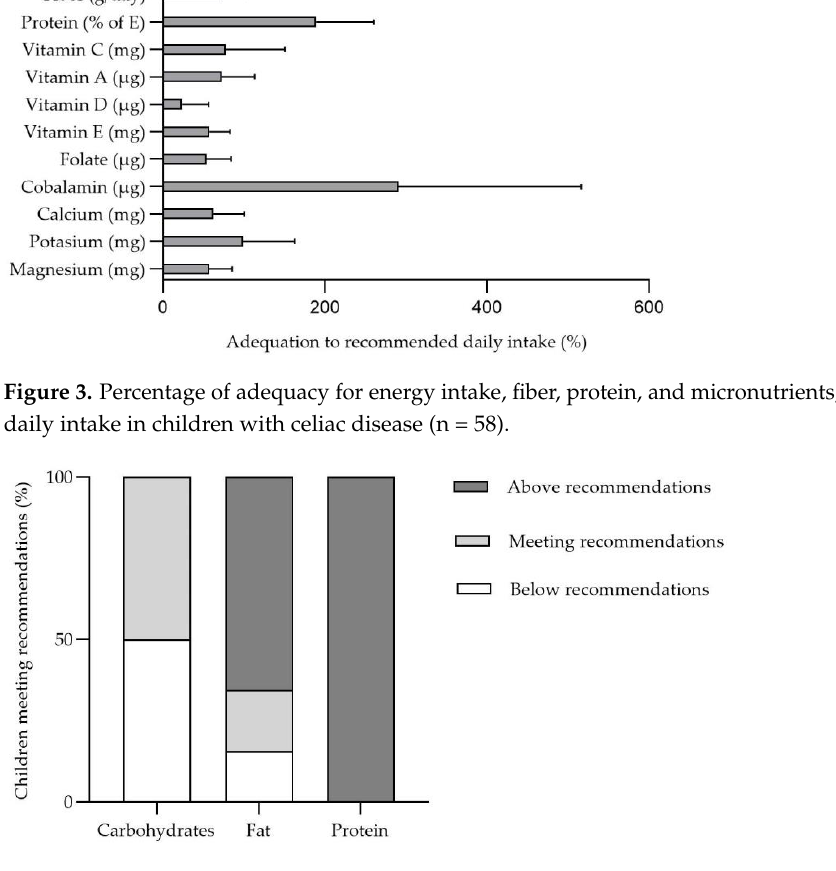
Figure 4. Children meeting European Food Safe Authority recommendations for carbohydrates, fat, and protein daily intakes. Table 2. Differences in dietary intake by fecal gluten immunogenic peptide detection (negative vs. positive).